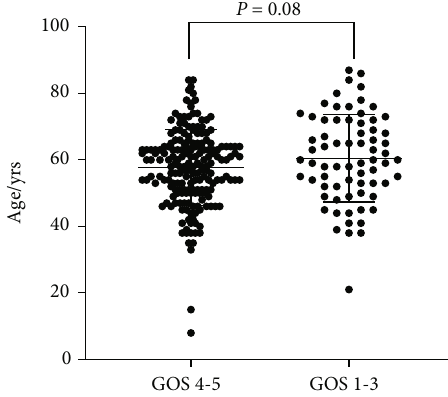
Figure 1: Age distribution of patients in di ff erent aSAH prognosis